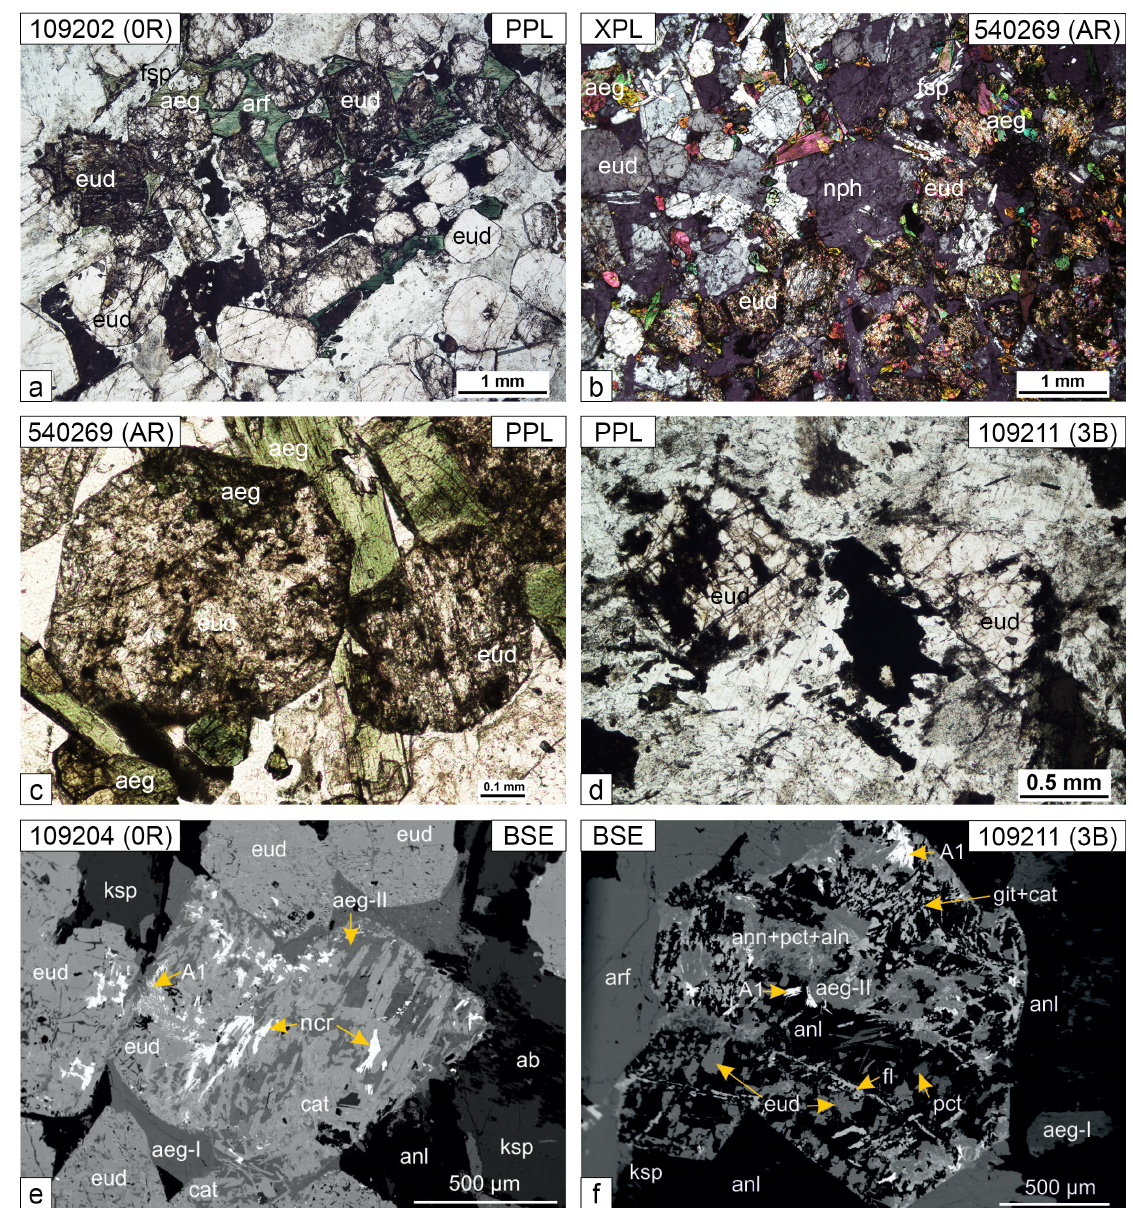
Figure 3. Photomicrographs and back scatter electron (BSE) images of selected samples: ( a ) altered and fresh octagonal eudialyte under plain polarised light (PPL); ( b ) altered and unaltered eudialyte under crossed polars (XPL), bright colours due to secondary catapleiite and aegirine and interstitial aegirine; ( c ) eudialyte pseudomorph with secondary aegirine; ( d ) partially altered eudialyte crystals; ( e ) altered eudialyte with secondary catapleiite, nacareniobsite-(Ce), A1, and aegirine; and ( f ) altered eudialyte with secondary gittinsite. Abbreviations are as follows: A1 = unnamed REE-silicate A1 (see [29]); aeg-I = primary aegirine; aeg-II = secondary aegirine; aln = allanite; anl = analcime; cat = catapleiite; eud = eudialye; fl = fluorite; git = gittinsite; ksp = K-feldspar; ncr = nacareniobsite-(Ce); nph = nepheline; and pct =